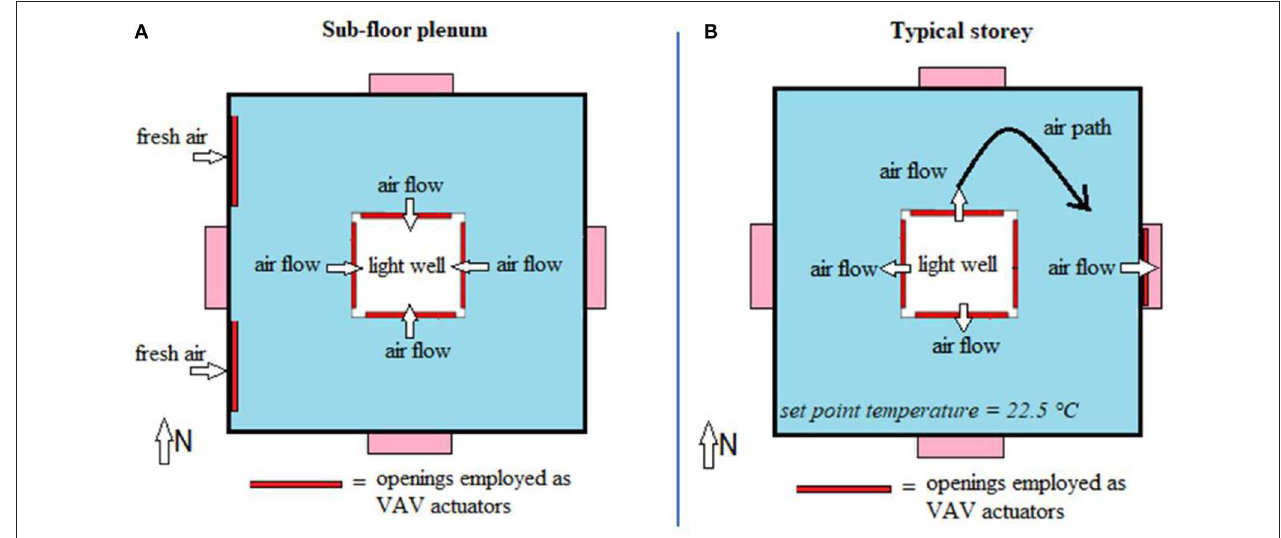
strategy). That’s why Hybrid 2 and Hybrid 3 adopt lower